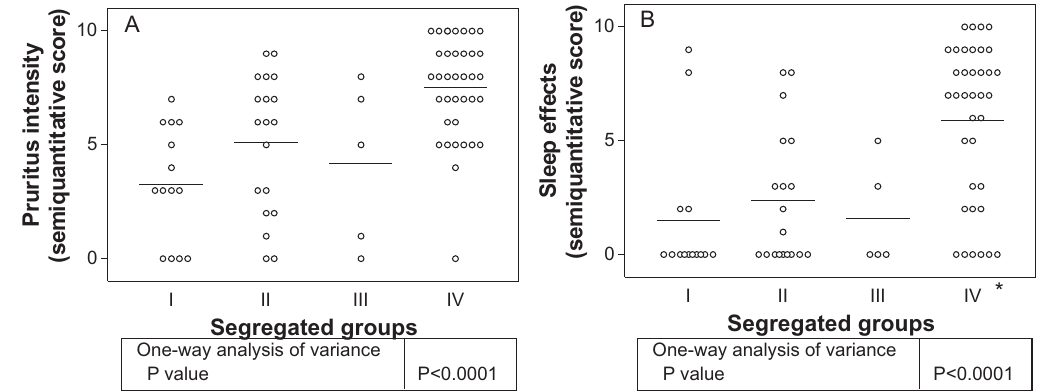
Figure 7 - Major symptoms analysis as pruritus(A) and sleep disturbances(B), evaluated by semiquantative scores as described in Methods, in AD Brazilian adult patients, segregated according methods and fig. 3. Bar represents mean value and table shows ANOVA analysis. (*) marks significant post hoc